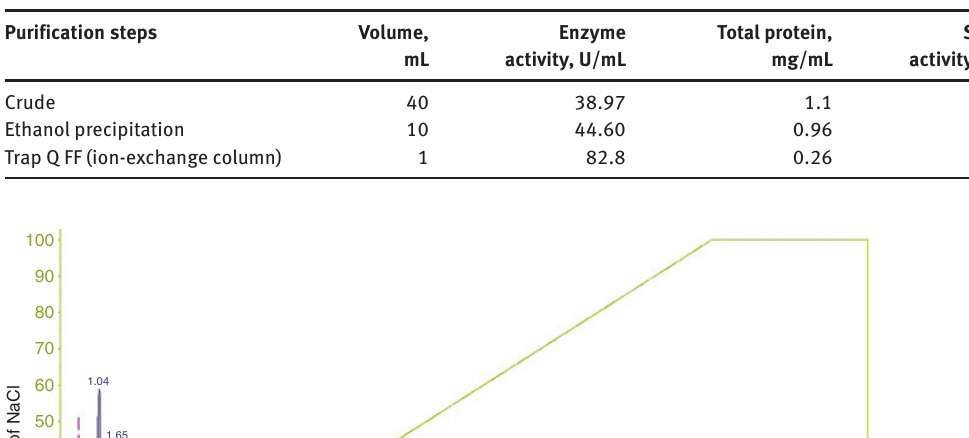
Table 1: Purification step of pterin deaminase.